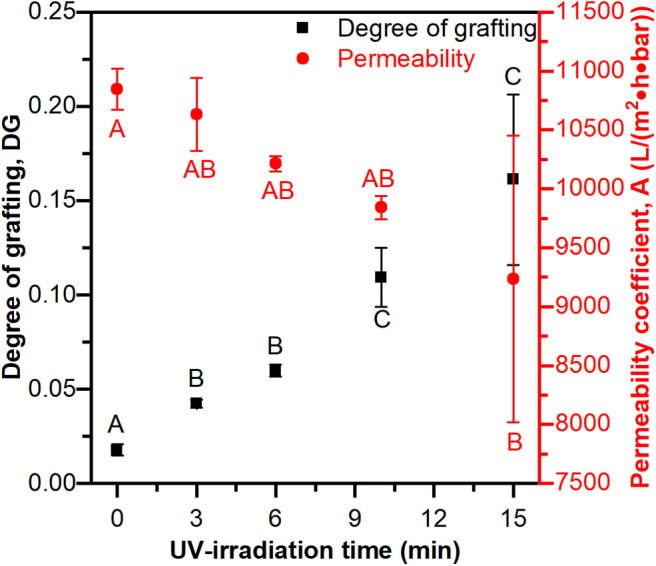
Degree of grafting and permeability coefficient as a function of different UV-irradiation time. Longer UV-irradiation time leads to a higher degree of grafting, but lower permeability. Data are represented as the mean ± the standard deviation (n = 3 separate membranes). Tukey's honestly significant difference post-hoc tests were performed on permeability data (red letters) and DG data (black letters) separately. Means that do not share a letter are significantly different (p < 0.05).